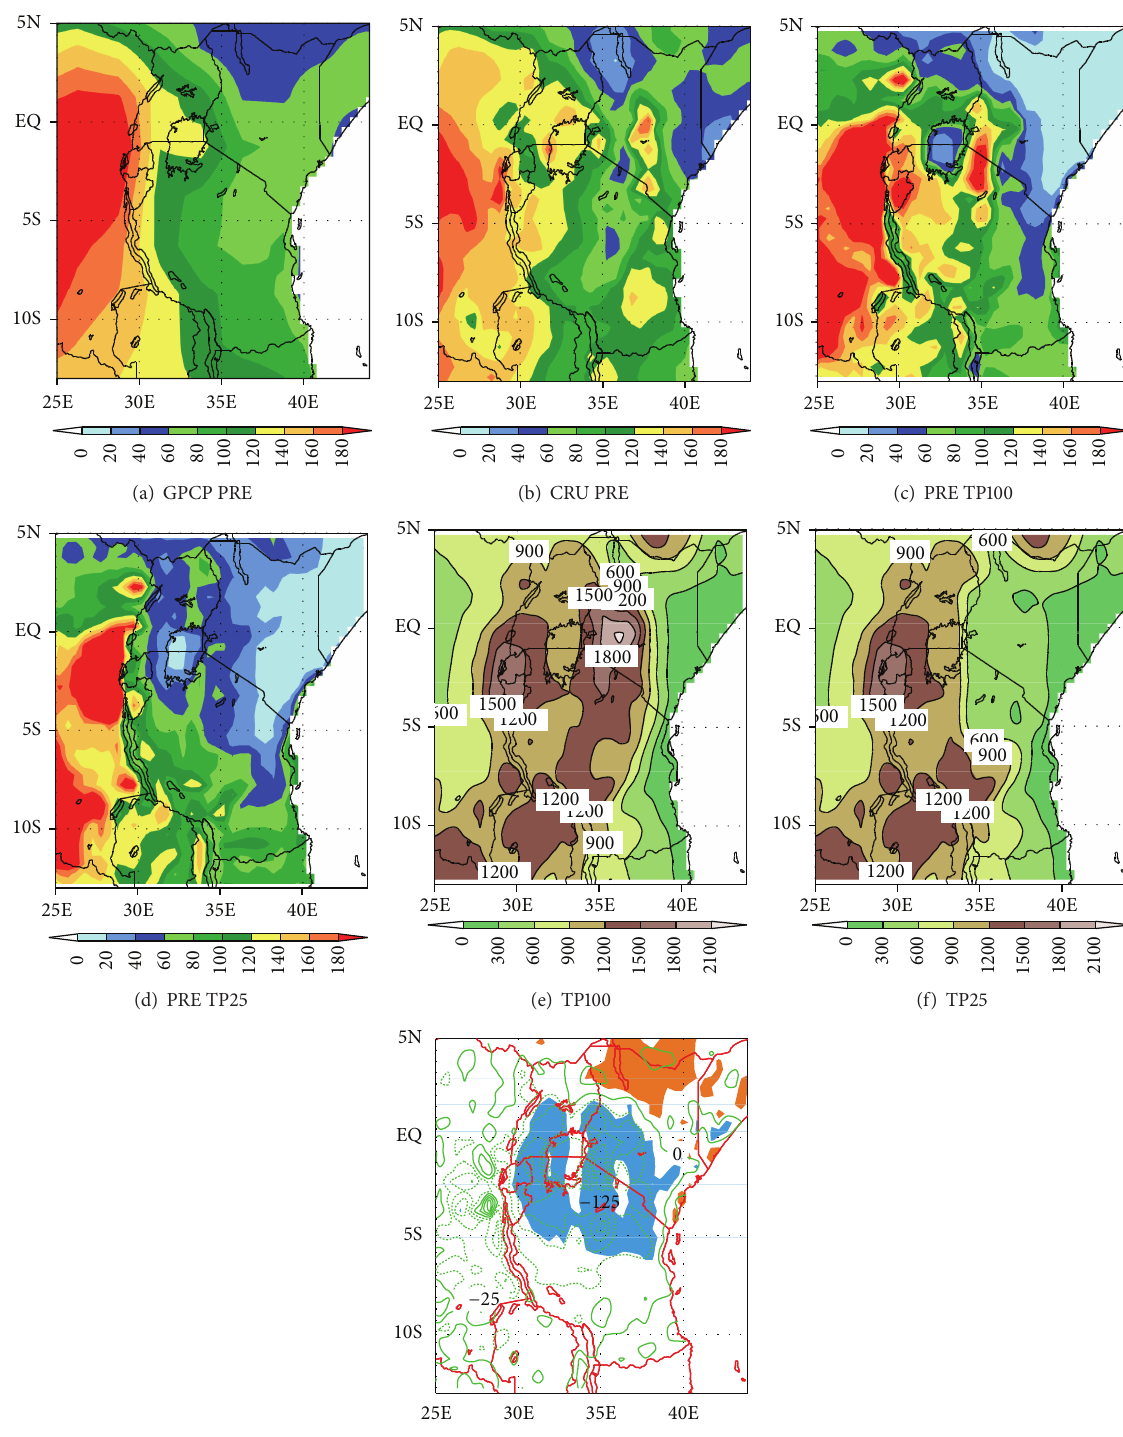
Figure 4: Climatology of OND rainfall (in mm) over the period 2000–2008: (a) GPCP observed rainfall, (b) CRU observed rainfall, (c) simulated using actual topography (TP100), (d) simulated using topography reduced to 25% (TP25) over 34 ∘ E–38 ∘ E and 6 ∘ S–2 ∘ N, (e) actual topography (TP100), (f) topography over KTU reduced to 25% (TP25), and (g) rainfall difference [(d) minus (c)] with contours (green) at 25 mm interval and the thick (black) contours represent regions over which the rainfall difference is zero. The shaded regions in (g) are significant at 95% confidence level ( where shaded blue ( orange ) implies decrease ( increase ) in rainfall )